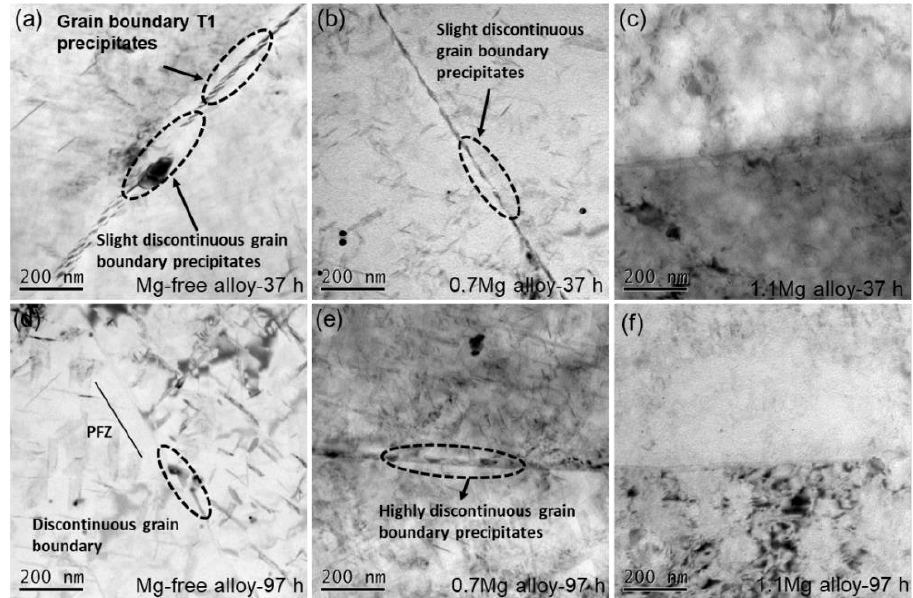
Figure 8. BF TEM images of Al–Cu–Li alloys with different Mg content (Mg-free alloy ( a , d ), 0.7Mg alloy ( b , e ), 1.1Mg alloy ( c , f )) aged at 150 °C for 37 h ( a – c ) and 97 h ( d – f ).